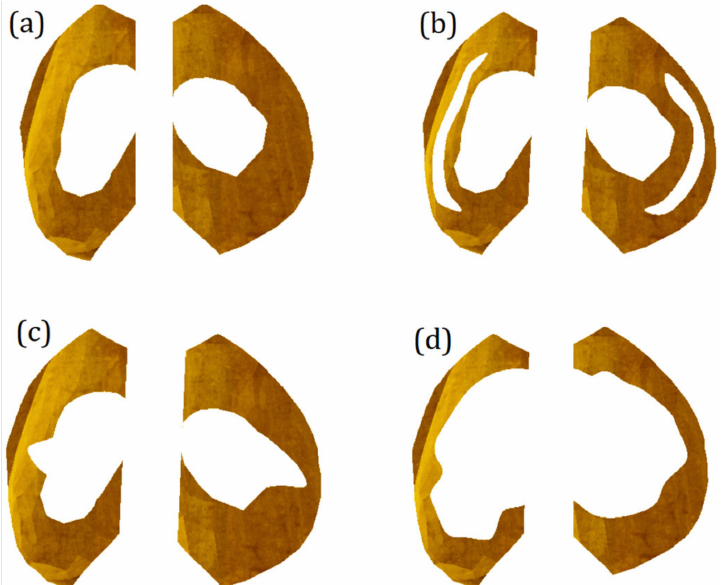
Figure 5. Possible variants of meniscus damage modeled by removing volume from its initial geometry: ( a ) relatively undamaged meniscus; ( b ) meniscus with a longitudinal tear; ( c ) meniscus with a radial tear; ( d ) complex